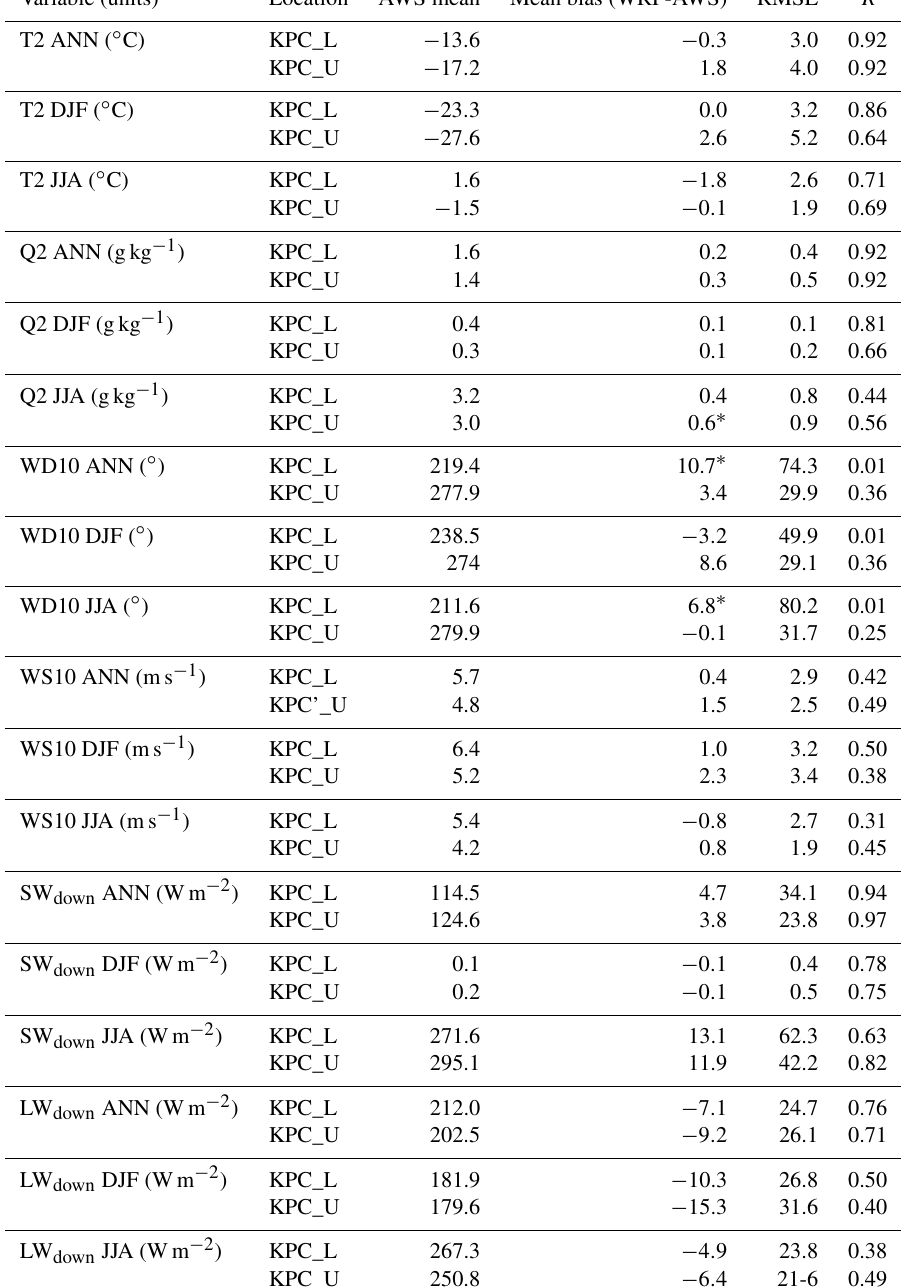
Table 2. Comparison of the near-surface WRF model output to AWS data at KPC_L and KPC_U. ANN refers to annual mean values, and DJF refers to winter average values whereas JJA refers to summer average values. Asterisks refer to statistically significant differences between WRF and AWS at the 99% confidence interval, using Student’s t